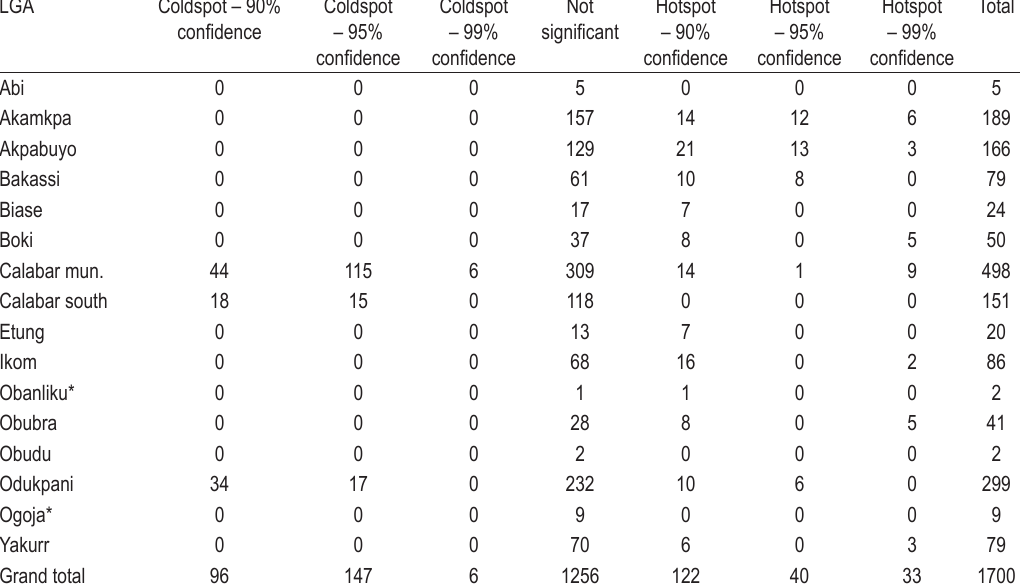
TABLE 1. Distribution of HTS points in within respective cluster types by local government areas LGA Coldspot –